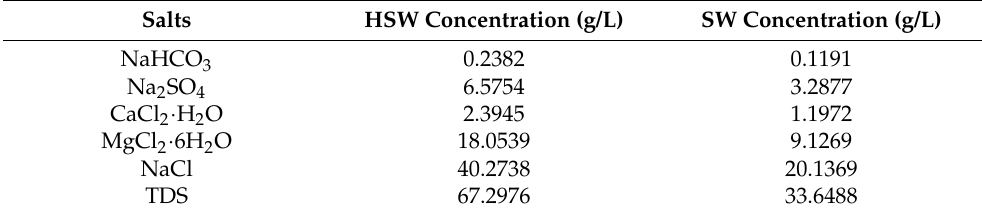
Table 1. Composition of HSW and SW based on Gulf reservoirs [29,30].